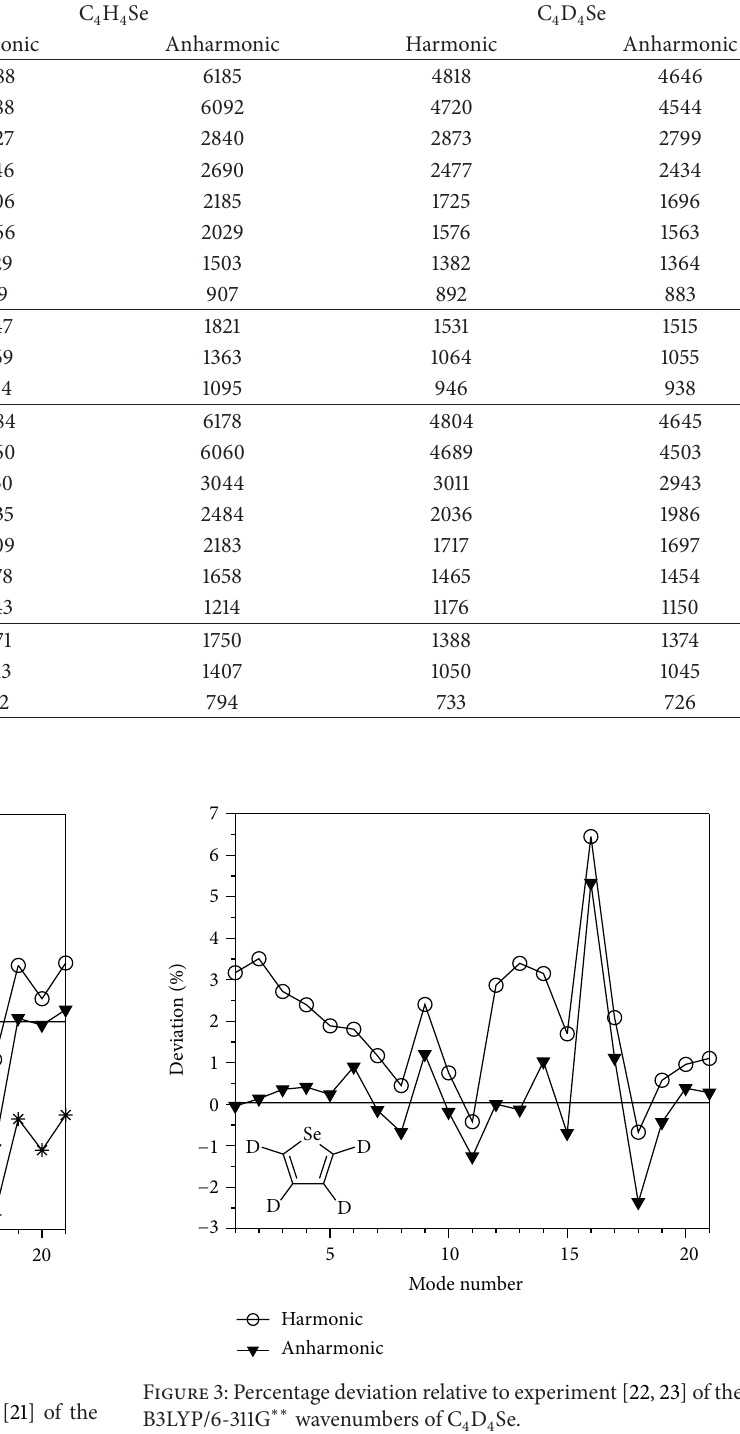
Table 4: B3LYP/6-311G ∗∗ first overtone wavenumbers (cm − 1 ) of selenophene isotopomers. Symm.